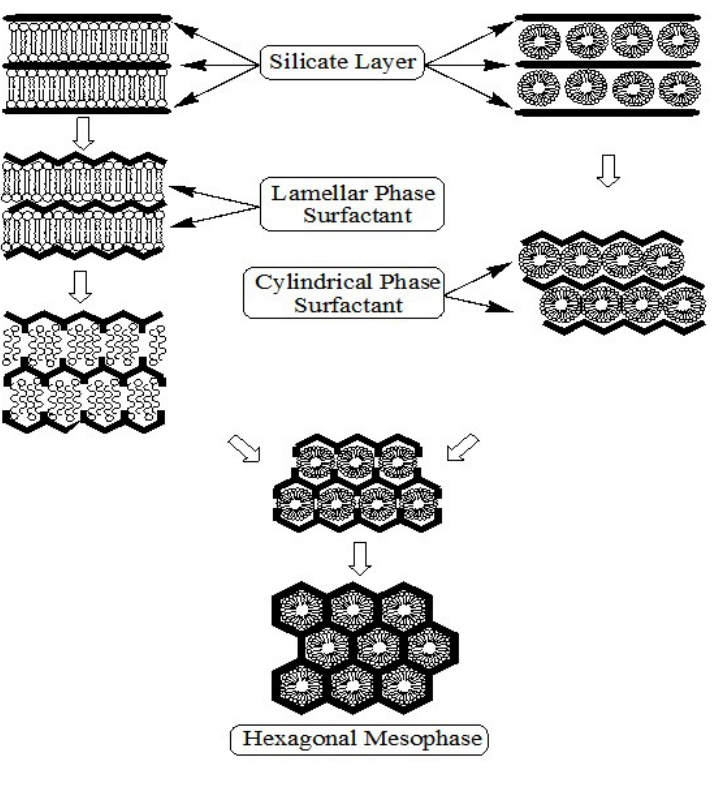
Figure 7. Schematic diagrams of the formation mechanism of MCM-41; ( a ) the proposed transformation mechanism by Monnier et al . [2] and ( b ) the formation mechanism proposed by Steel et al.